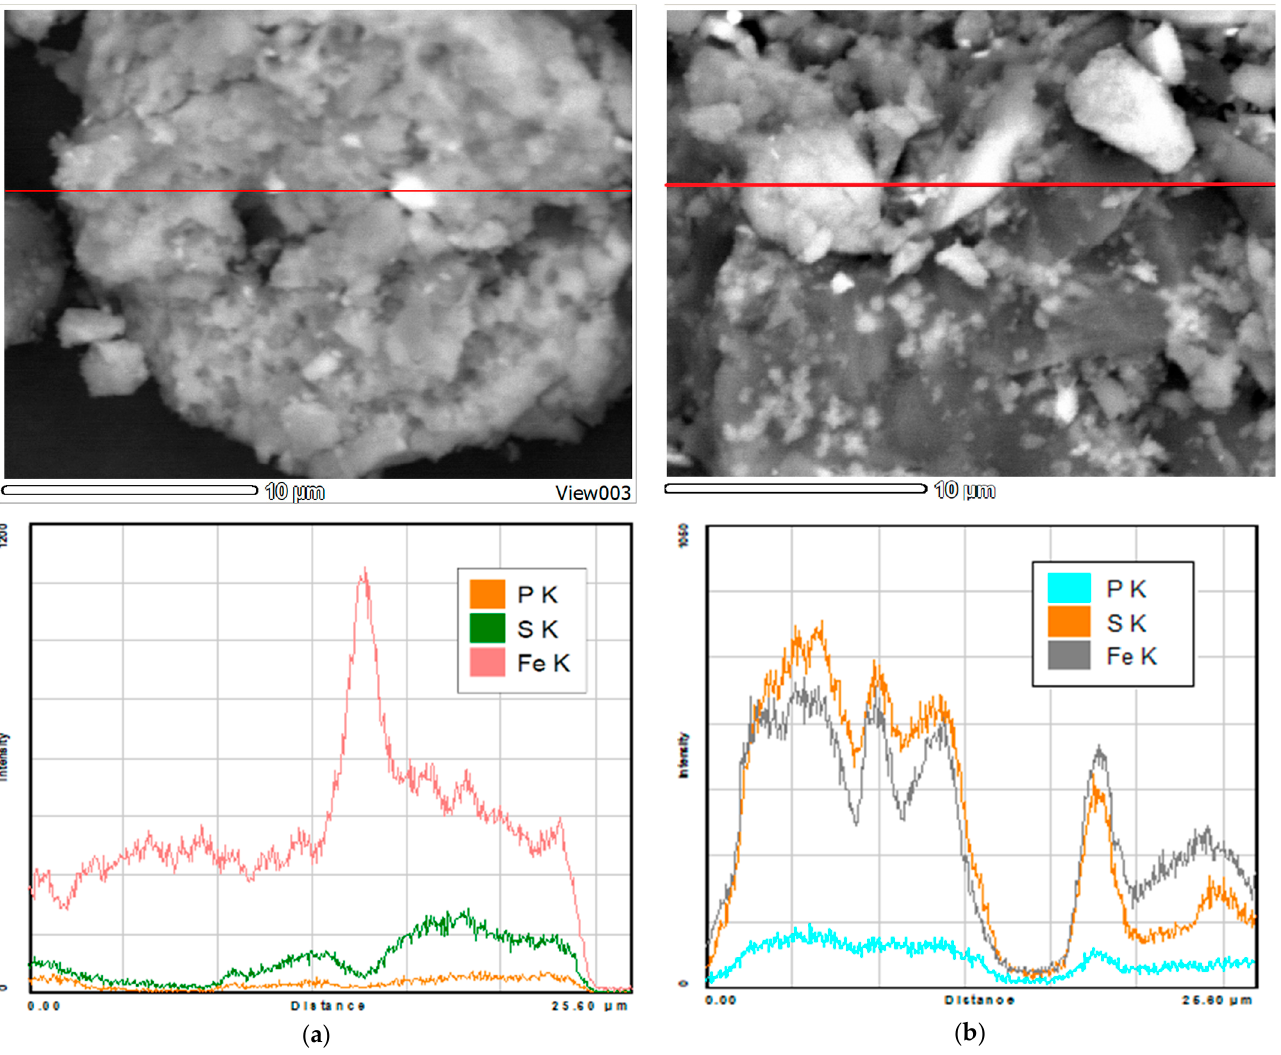
Figure 14. SEM images (BEC) of the roasted RM with 13.65% Na 2 SO 4 at 1200 °C for 5 ( a ) and 30 ( b ) min with correlation plots for P, S, and Fe intensity on the scan line. Red line indicates to profile cut